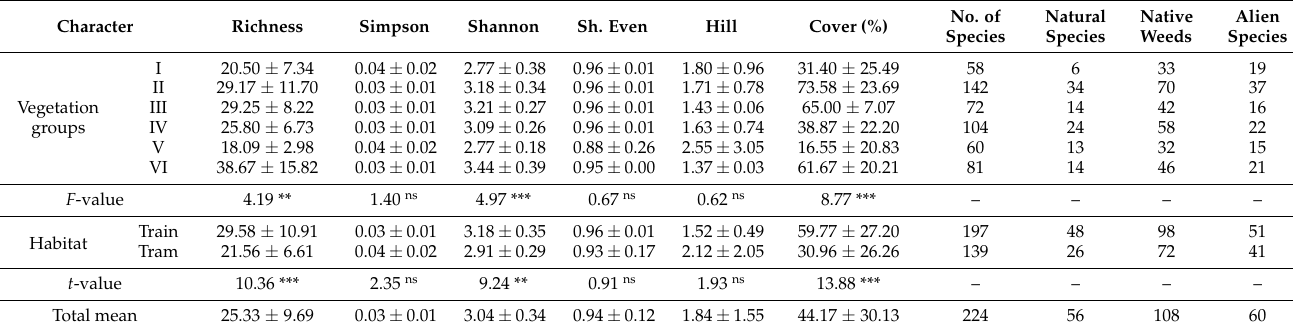
Table 2. Components of plant diversity in the habitats and 6 vegetation groups identified in the present study. The vegetation groups are I: Urospermum picroides , II: Chenopodium murale , III: Malva parviflora , IV: Cynodon dactylon , V: Hordeum leporinum , and VI: Sonchus oleraceus. F -values represent one-way ANOVA, degrees of freedom ( df ) = 5. t -values represent Student’s t -test. **: p < 0.01, ***: p < 0.001, ns : not significant (i.e., p > 0.05).